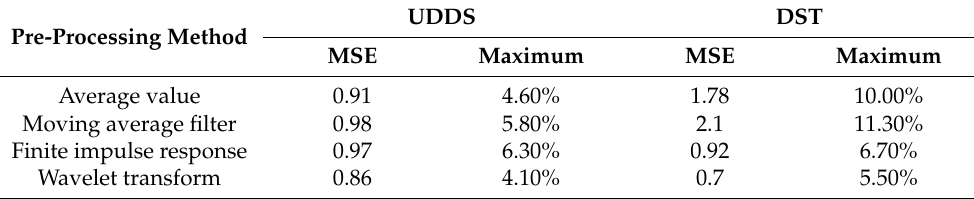
Table 6. Maximum error and MSE of two profiles with different pre-processing methods.